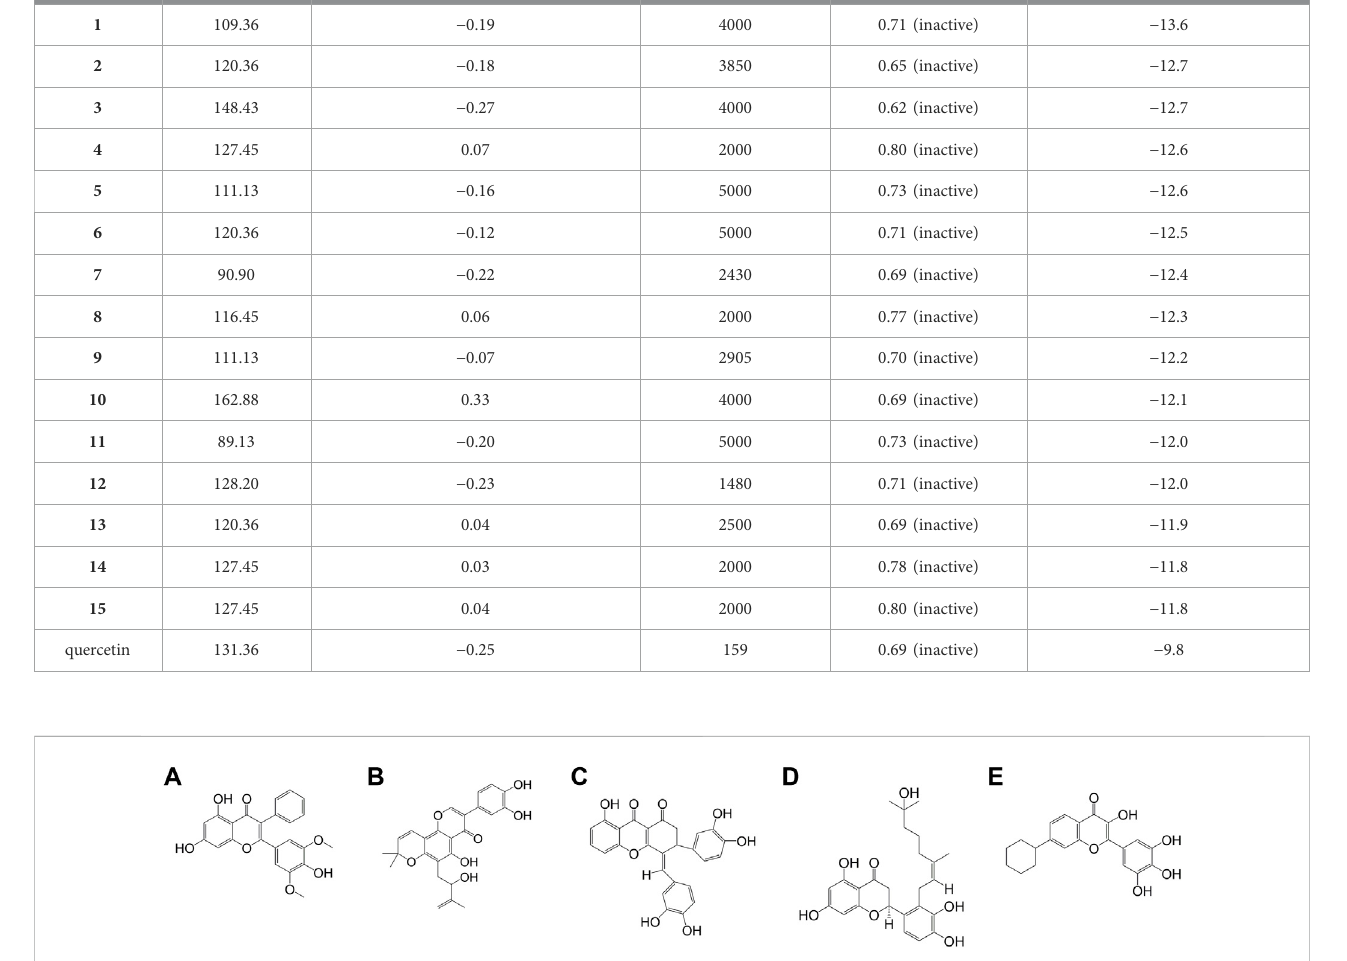
FIGURE 4 The chemical structure of COMPs (A) COMP 1 , (B) COMP 2 , (C) COMP 3 , (D) COMP 4 , and (E) COMP 5